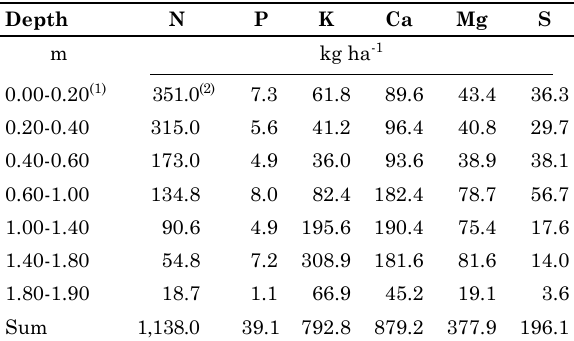
brazil.table 3. Stock of nutrients available in